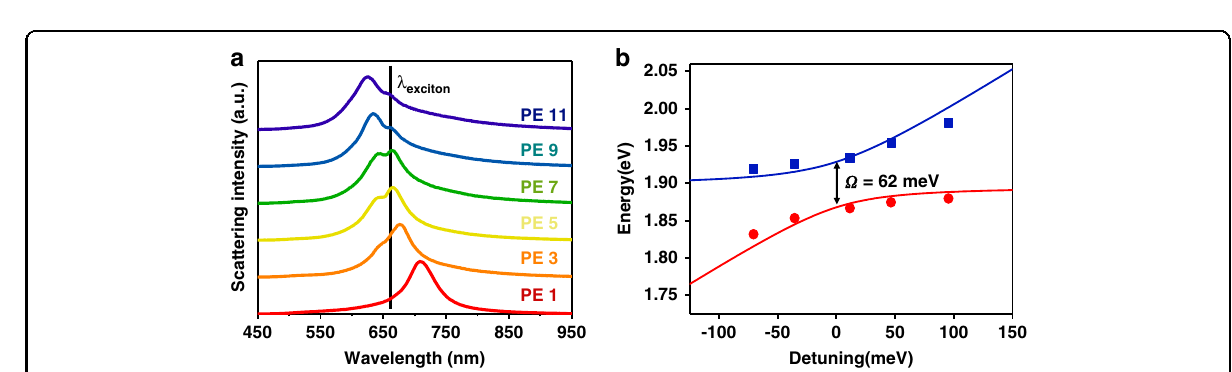
Fig. 2 The dark- fi eld scattering spectrums study of plasmon-exciton system with different thicknesses of PE layers. a Dark- fi eld scattering spectrums of above gap-mode nanocavity with various thicknesses of PE layers. b The energy of the upper branch hybrid state energy (red) and the lower branch hybrid state energy (blue) as a function of